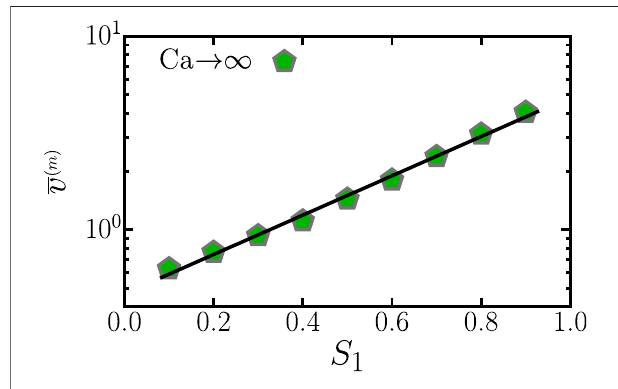
FIGURE 5 | Log-linear graph showing that, for Ca → ∞ , the behavior of the temporal average velocity can be described by an exponential function of the fi lling fraction, (cid:1) v ( m ) ∝ e ( δ S 1 ) , where S 1 is the saturation of phase 1 (the less viscous phase) with exponent δ = 2.34 ± 0.07, for M = 10 and ∇ P = 1.0